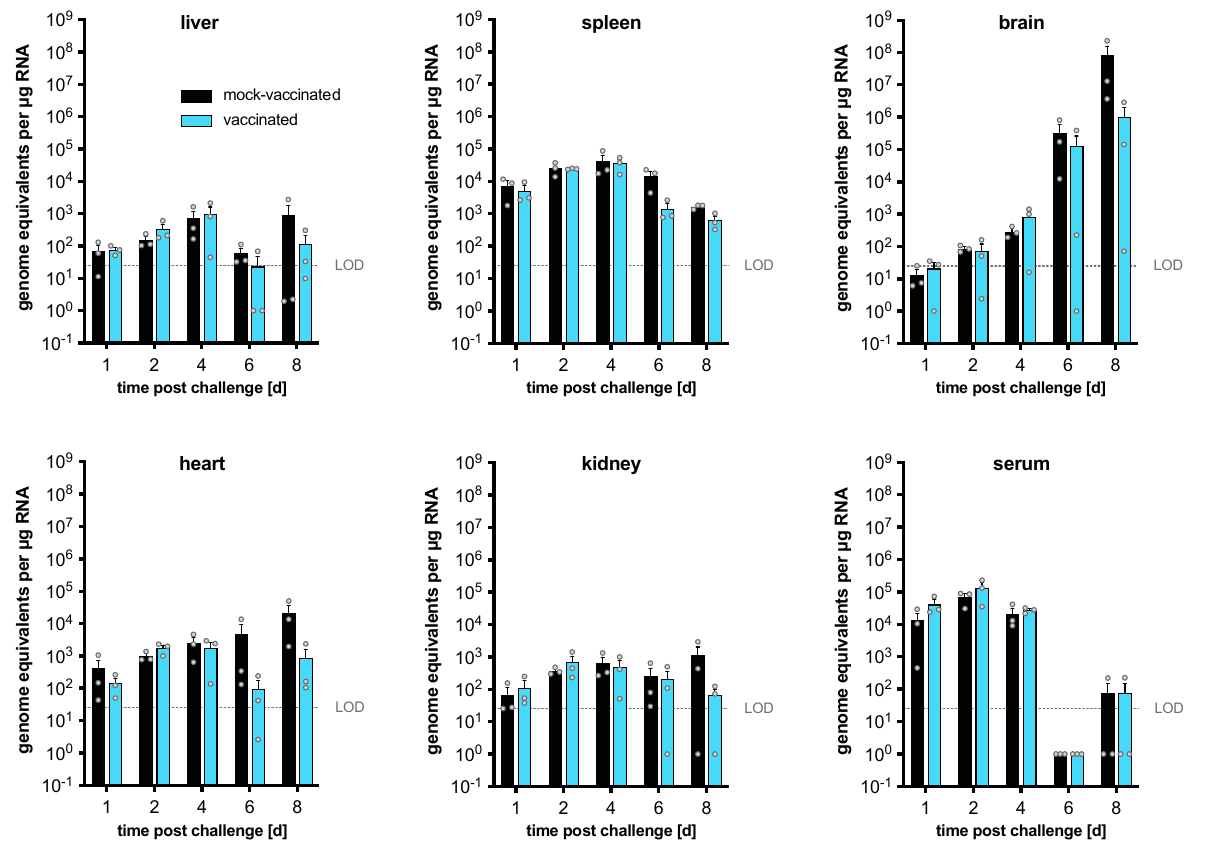
Figure 6. In vivo replication kinetics of WT DTV in naïve and vaccinated BL6 mice. BL6 mice were vaccinated with 10 3 PFU of CIGM (or PBS as control) in a two-dose regimen, followed by lethal WT DTV challenge 28 d after the last vaccination. At one, two, four, six, and eight days post challenge, groups of three mice were sacrificed to harvest sera and organs, including liver, spleen, brain, heart, and kidney. Viral RNA was extracted and quantified by RT-qPCR. The limit of detection (LOD) is 25 genome equivalents per µg RNA . Graphs are organized by tissue and each grey dot represents the mean viral genome equivalents from an individual mouse from three technical replicates. Bars represent mean values from n = 3 mice; error bars indicate the SEM. None of the observed di ff erences between vaccinated or mock-vaccinated mice were statistically signi fi cant.